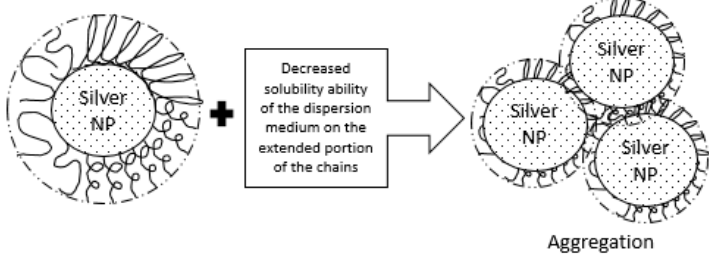
Figure 6. Schematic diagram of purposed mechanism of aggregation.